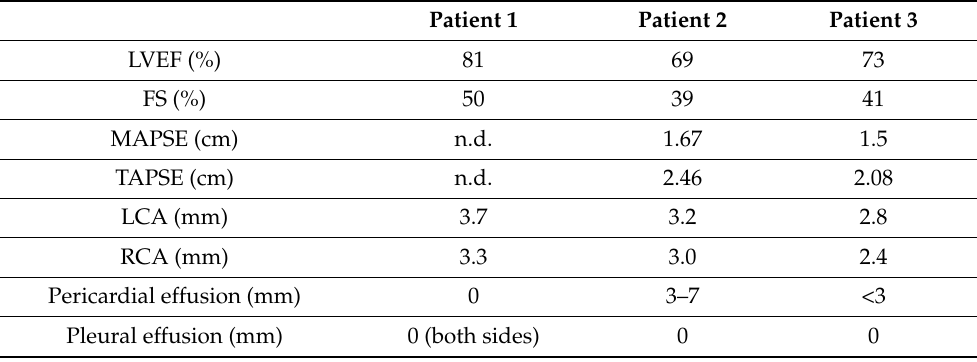
Table 5. Echocardiographic findings after